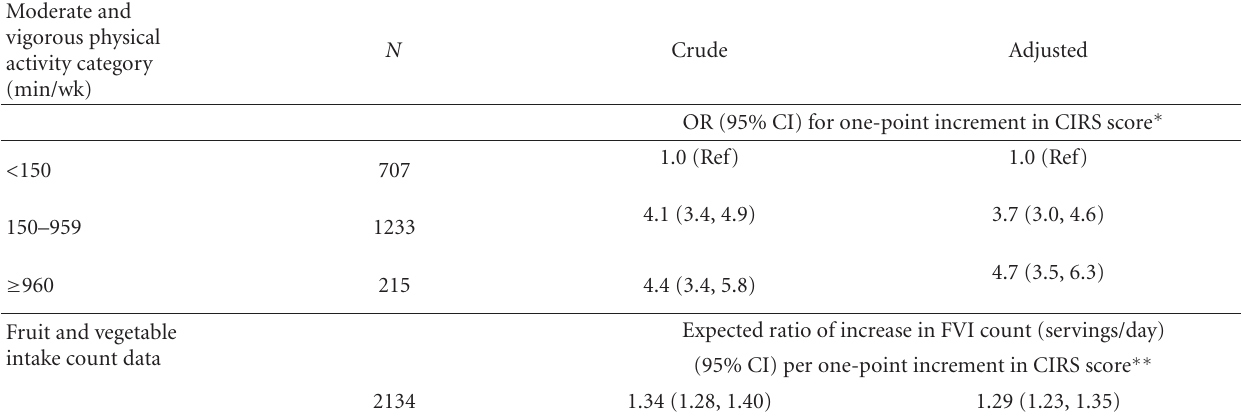
Table 3: Associations of score on 9 items of the CIRS (0–4 scale) with self-reported moderate and vigorous physical activity and self-reported fruit and vegetable